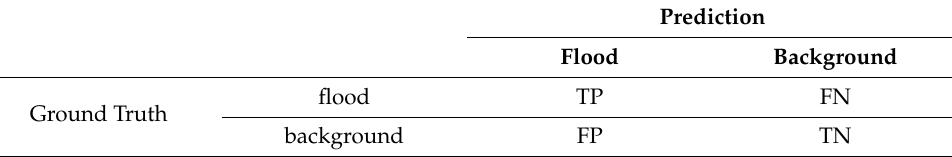
Table 3. The confusion matrix.